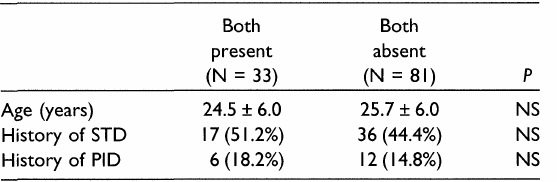
TABLE C. M. hominis plus U. urealyticum and epidemiologic